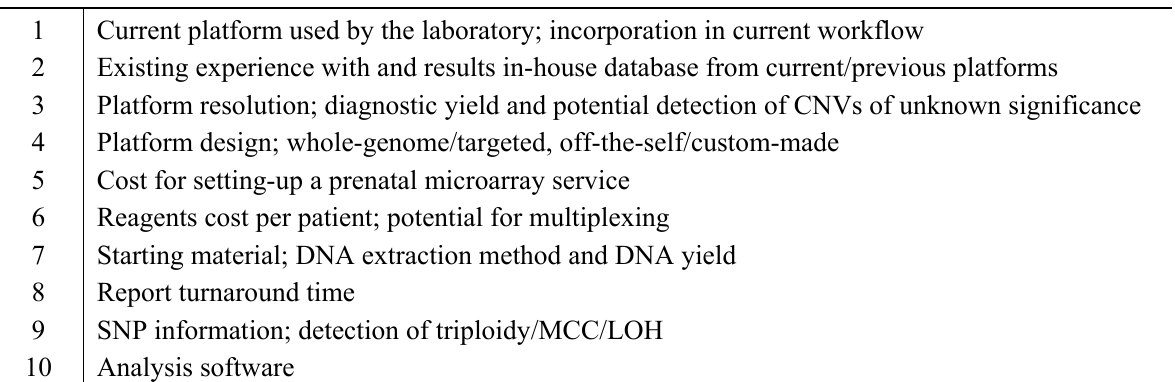
Table 2. Choosing a microarray platform